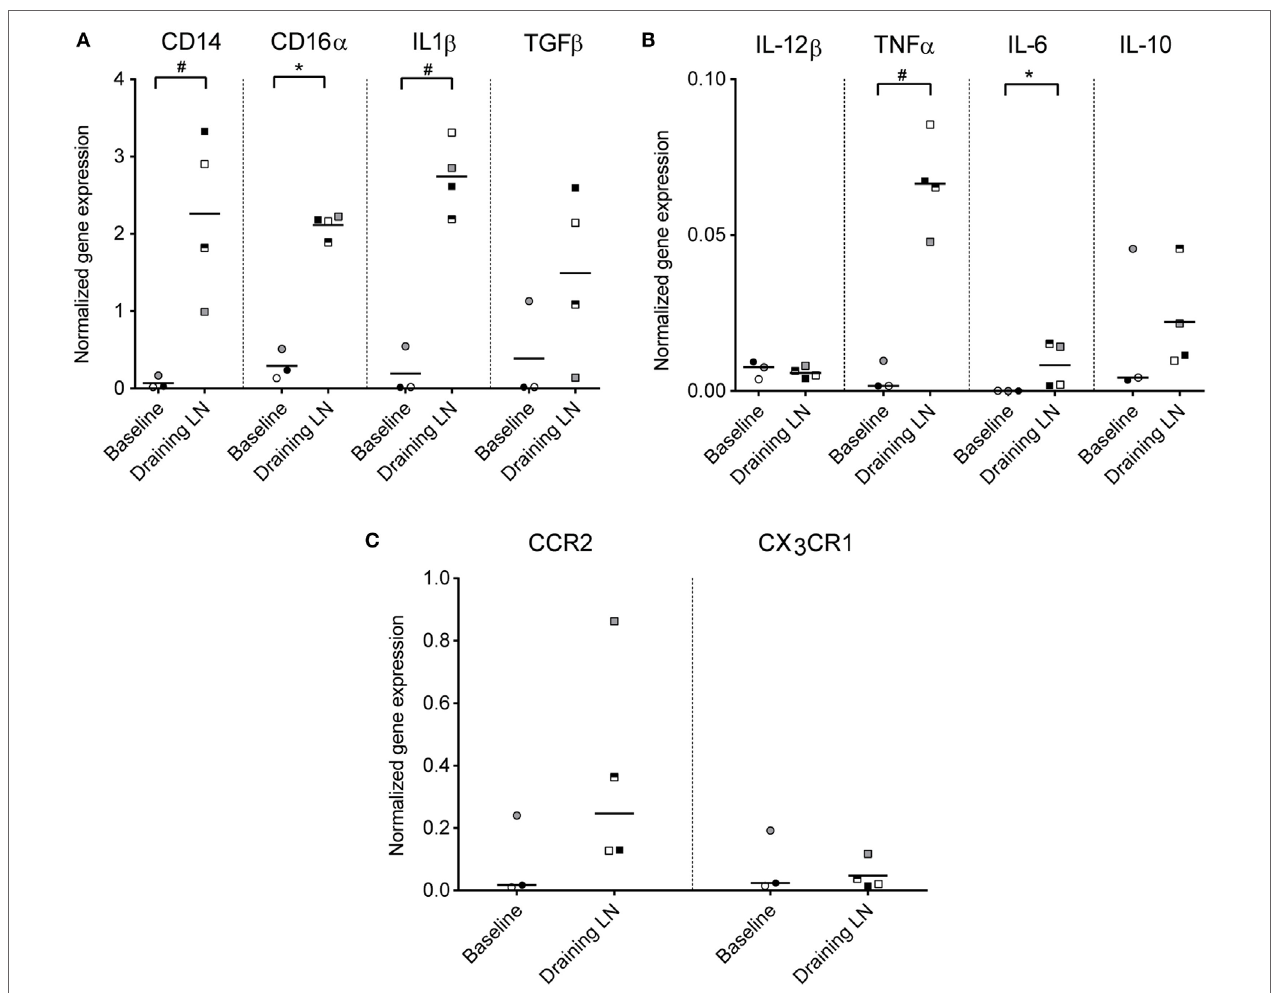
FigUre 7 | gene expression of monocytes from the draining ln . Gene expression levels (normalized to the reference gene PPIA ) of CD14 + cells isolated from blood (baseline non-injected) and from the draining LN at 24 h post-injection, as analyzed by RT-qPCR. Symbols represent individual animals and the median value within each group is depicted as a line. Statistical significant differences between the two groups using the unpaired t -test (for normally distributed data) are indicated as # P ≤ 0.05, and the Wilcoxon rank-sum test (for non-normally distributed data) are indicated as * P ≤ 0.05. (a) Gene expression levels of CD14, CD16 α , IL-1 β , and TGF β . (B) Gene expression levels of IL-12 β , TNF α , IL-6 , and IL-10 . Note the difference in y -axis range from (a) . (c) Gene expression levels of chemokine receptors CCR2 and CX 3 CR1 . Note the difference in y -axis range from (a,B)